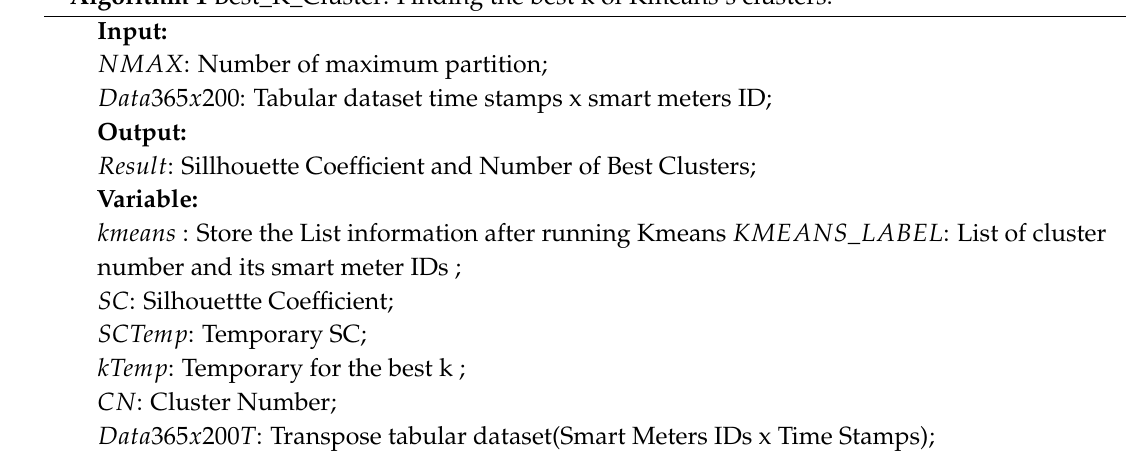
Algorithm 1 Best_K_Cluster: Finding the best k of Kmeans’s